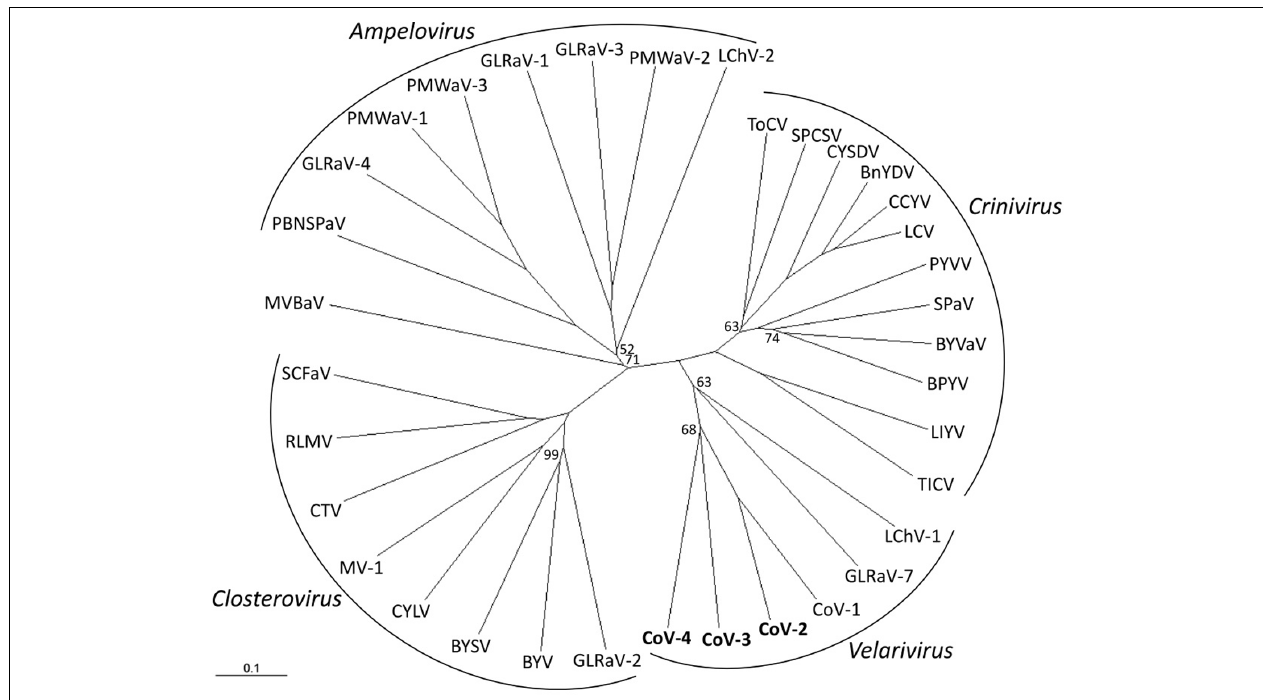
FIGURE 2 | Phylogenetic placement of Cordyline virus 2 (CoV-2), CoV-3, and CoV-4 within the family Closteroviridae using the combined RNA-dependent RNA polymerase, heat shock protein 70 homolog, p60, and coat protein amino acid sequences with a neighbor-joining algorithm and 1000 bootstrap replications. Branch support is indicated in percentage support, and is 100% unless indicated, and the scale provides branch distance for the given number of substitutions.Virus abbreviations (GenBank accession numbers) are: Genus Ampelovirus : GLRaV-1, Grapevine leafroll associated virus 1 (AF195822); GLRaV-3 (NC_004667); GLRaV-4 (NC_016416); LChV-2 (AF416335); PBNSPaV, Plum bark necrosis stem pitting associated virus (YP_001552326); PMWaV-1, Pineapple mealybug wilt associated virus 1 (AF414119); PMWaV-2 (AF283103); PMWaV-3 (DQ399259); Genus Closterovirus : BYSV, Beet yellow stunt virus (U51931); BYV, Beet yellows virus (AF190581); CTV, Citrus tristeza virus (NC_001661); CYLV,